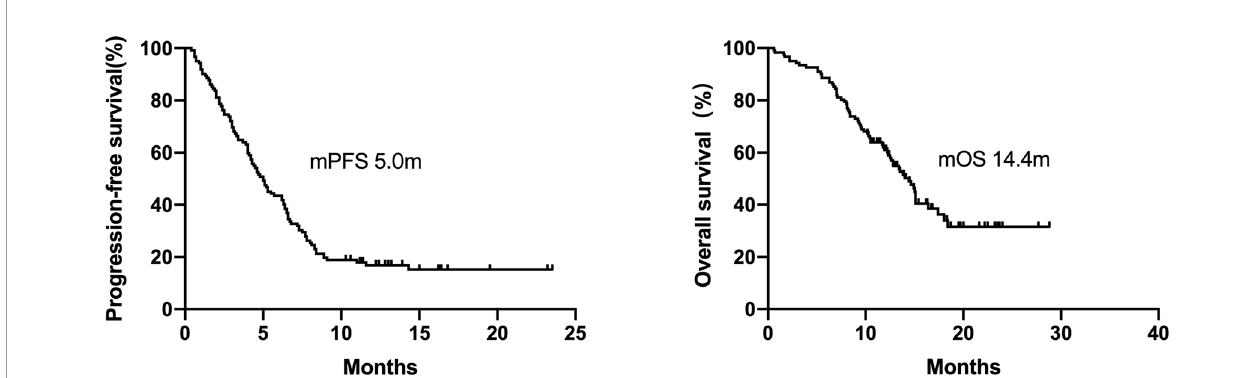
FIGURE 1 | Kaplan – Meier curves for progression-free survival and overall survival of patients with EGFR-mutant NSCLC (n = 122). The median PFS and OS were 5.0 months and 14.4 months,